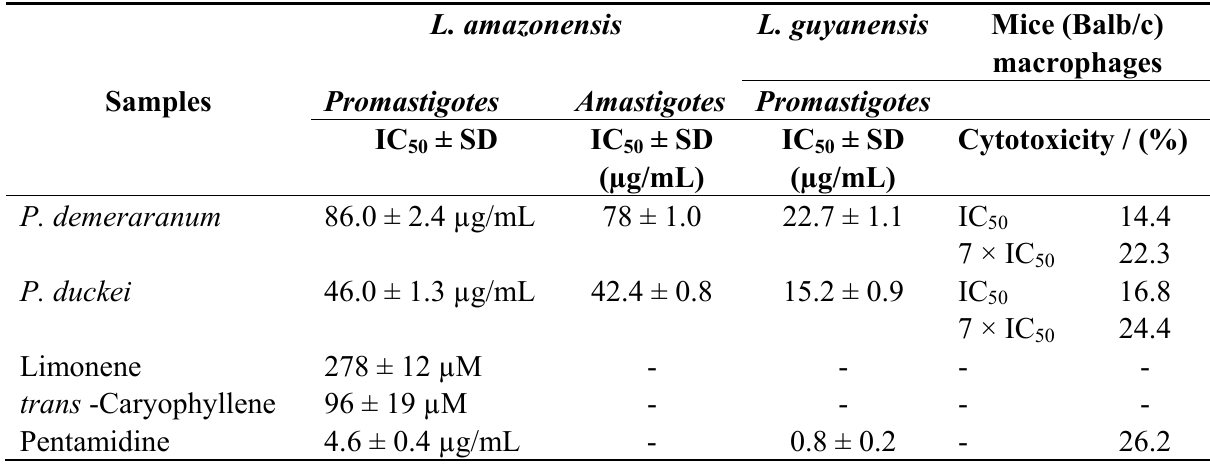
Table 2. Leishmanicidal and Cytotoxicity Activities of Piper demeraranum and P. duckei Essential